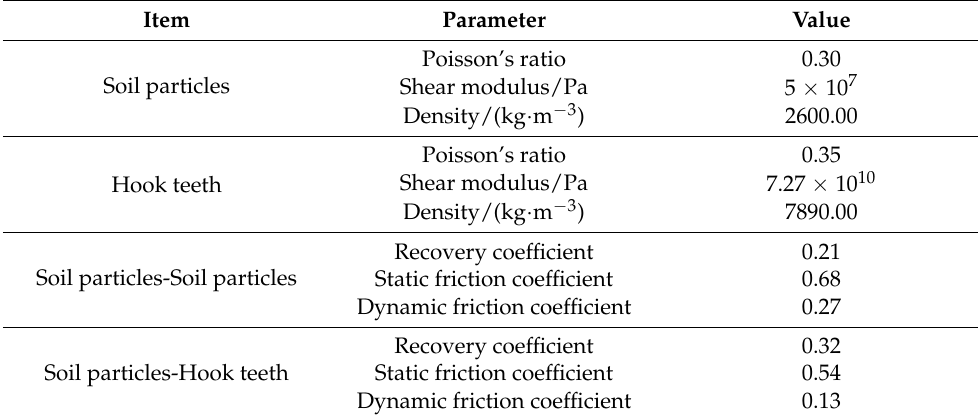
Table 6. The simulation parameter settings of soil particles and geometry.